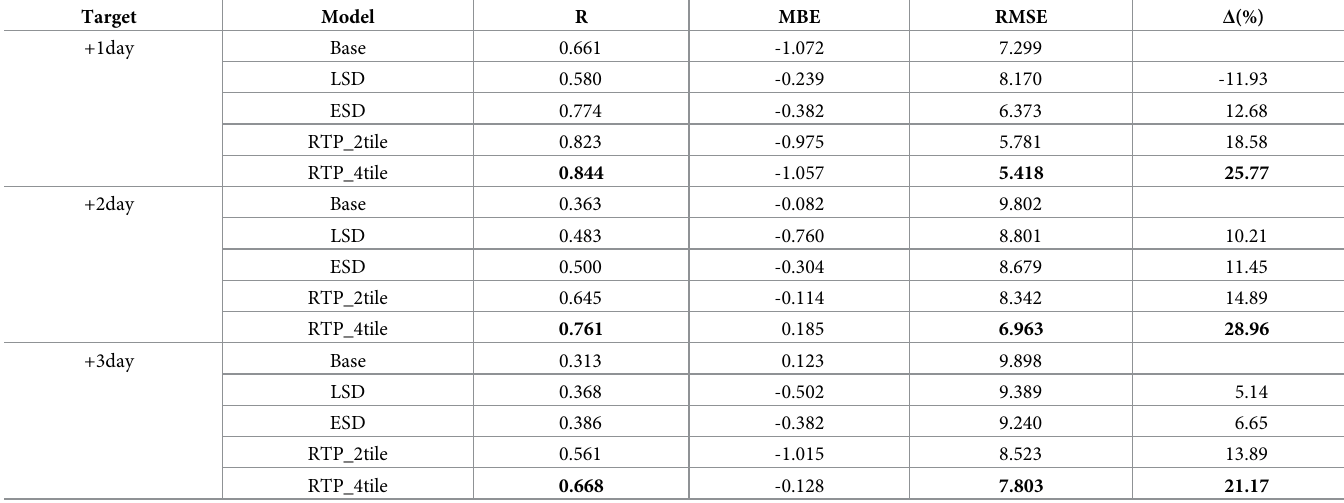
Table 2. Results for the Base, LSD, ESD and RTP models (the number of samples N = 6390, 12744, 18954.).